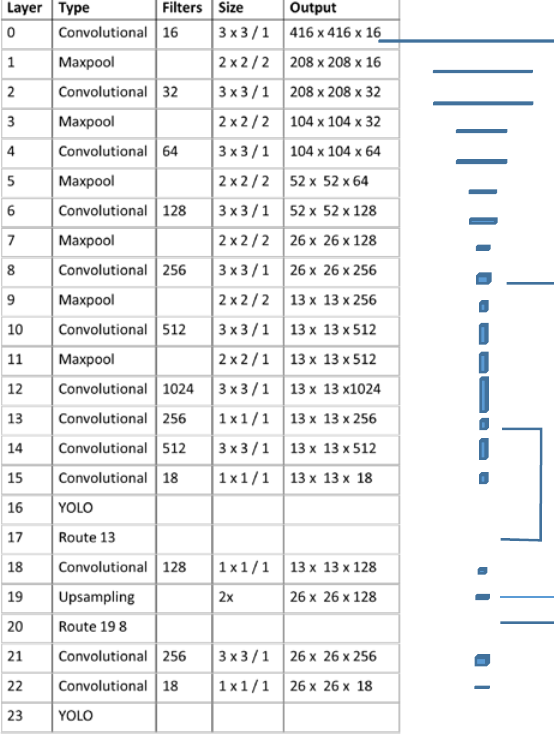
Figure 2. The layers of the yolov3-tiny convolutional neural network. The size of an incoming image is 416 x 416 x